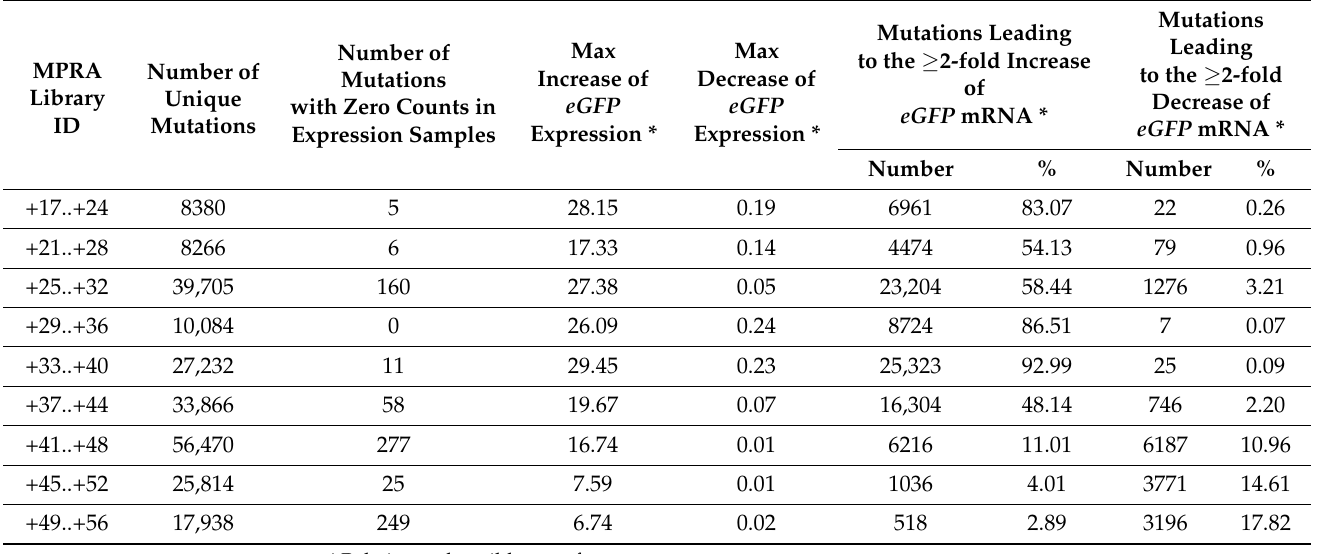
Table 2. Number of mutations influencing the eGFP expression in the MPRA libraries.